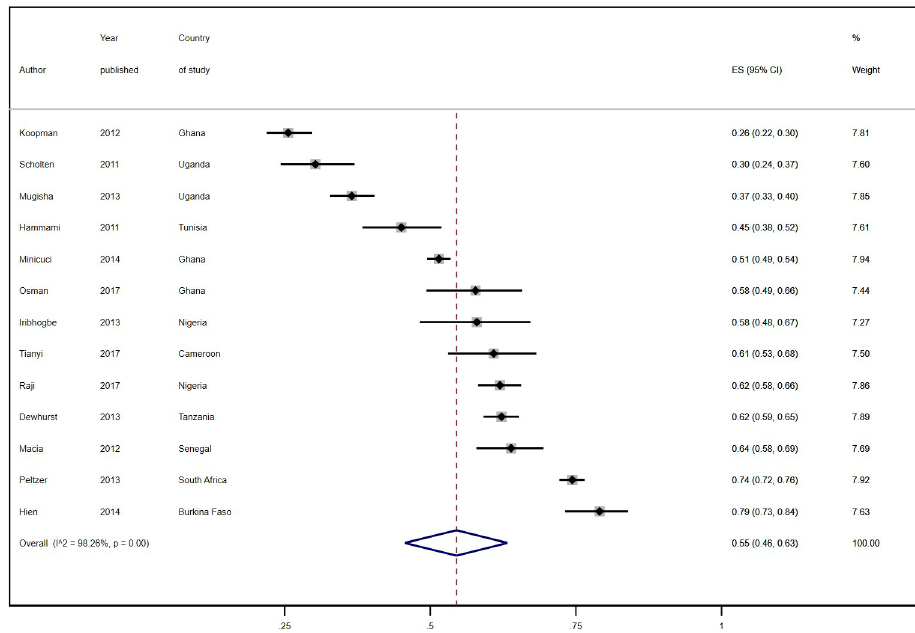
Fig 4. Prevalence estimates of hypertension in male subjects.